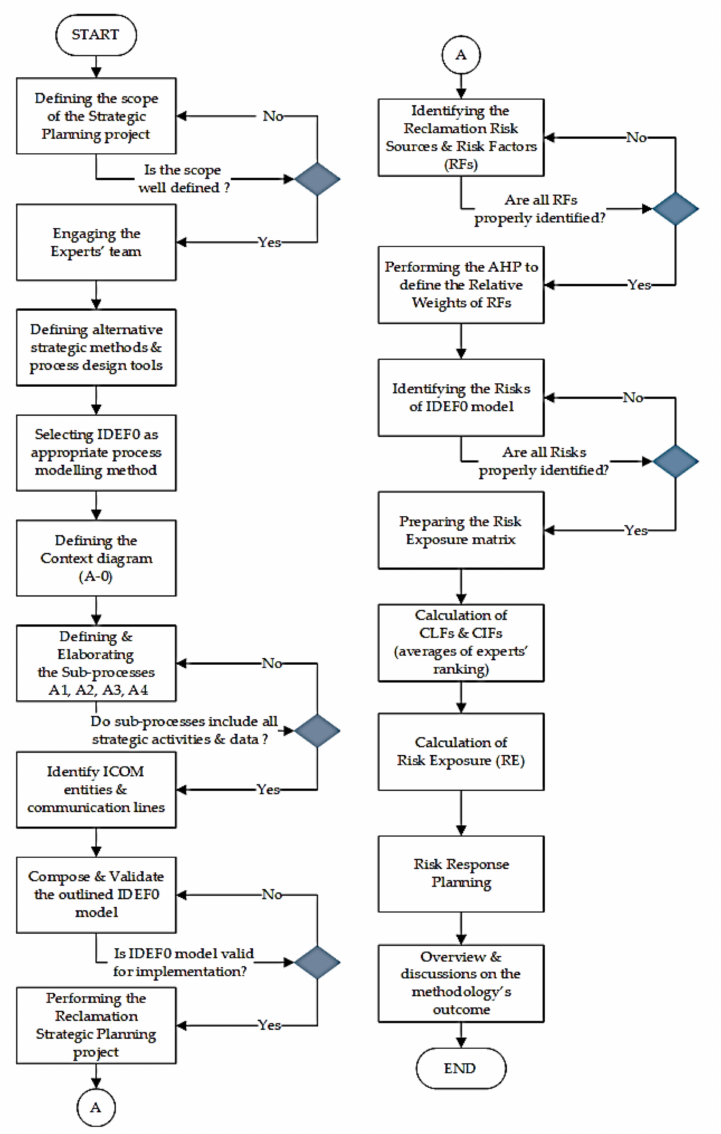
Figure 1. Flow chart of the applied